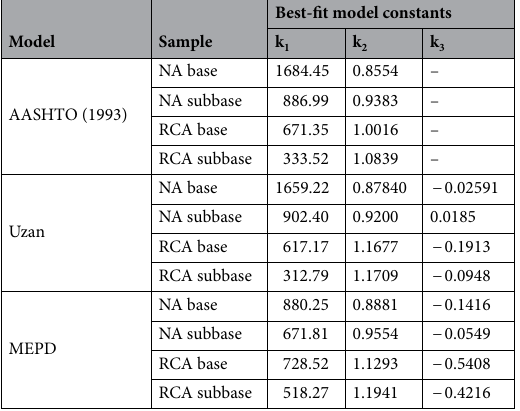
Table 2. Model parameters obtained for the subbase and base